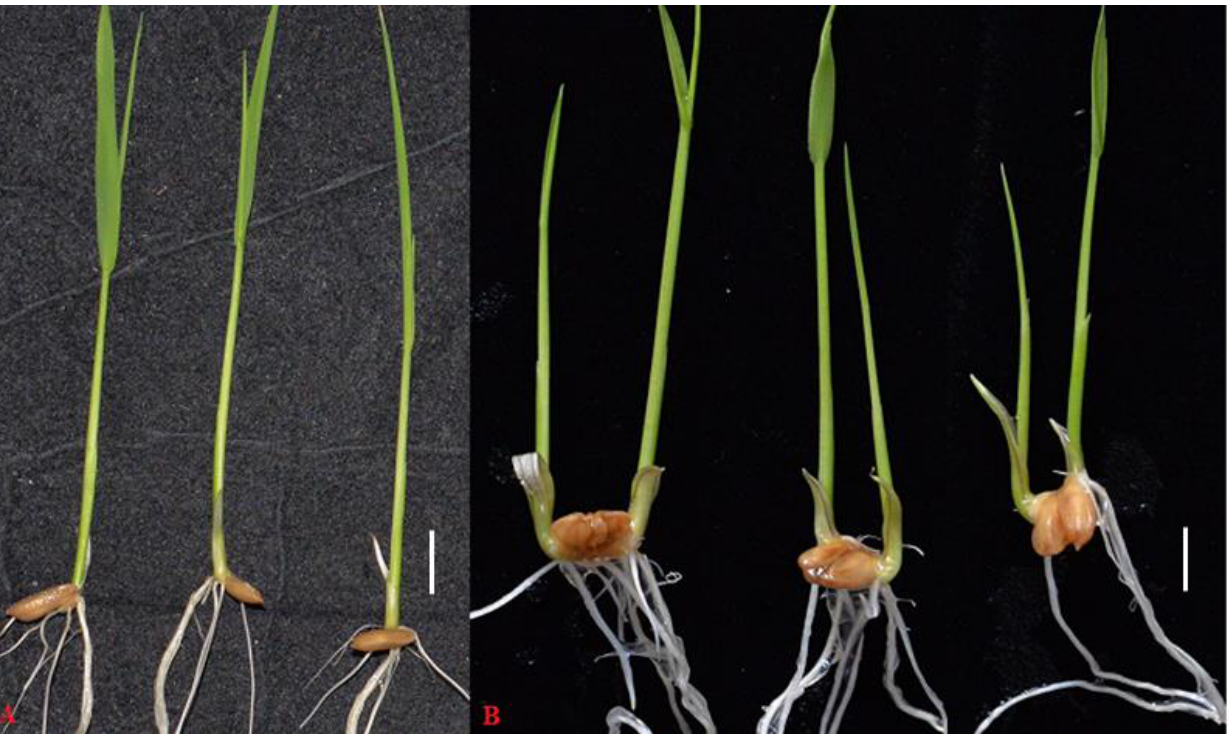
Figure 2. Mutant mp3 and wild-type rice at seedling stage. ( A ) Wild-type rice at seedling stage. ( B ) Mutant mp3 at seedling stage.